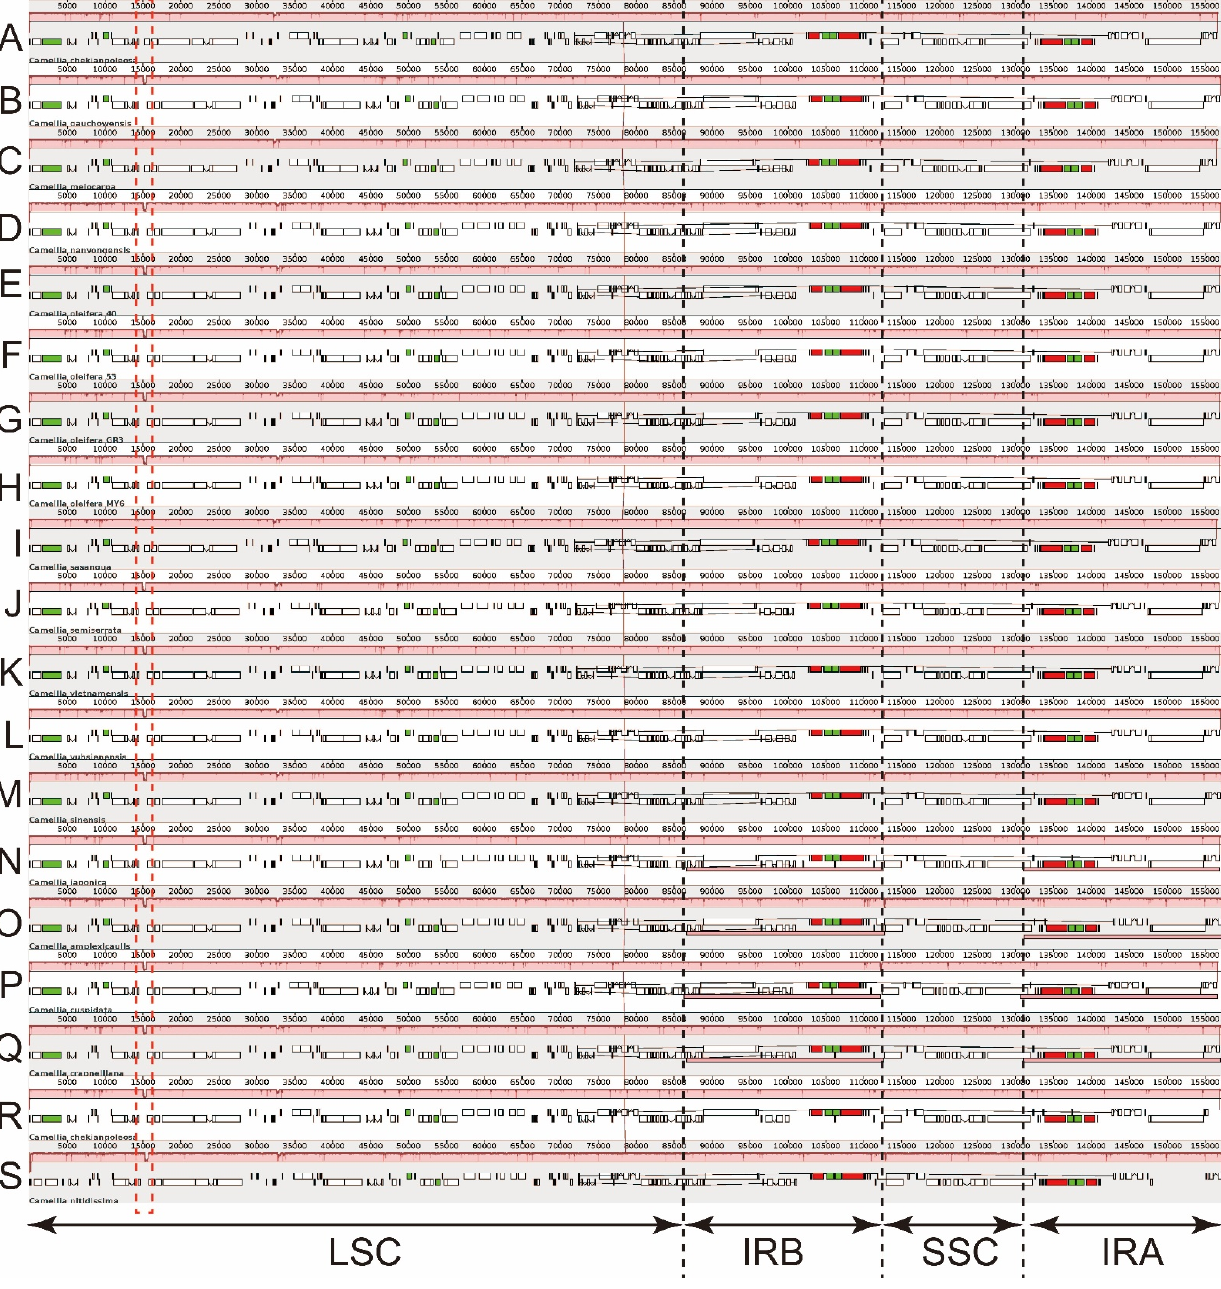
Figure 5. Mauve alignment of the 19 Camellia cp genomes. The C. chekiangoleosa var. Baihua genome is shown at the top as the reference genome. Within each alignment, the pink blocks represent the sequence similarity with the other genomes. The white, green, and red blocks represent protein- coding, tRNA, and rRNA genes, respectively. The regions in the red dotted box are the sequences with high divergence, which include the intergenic regions of atpH - atpI . A, C. chekiangoleosa